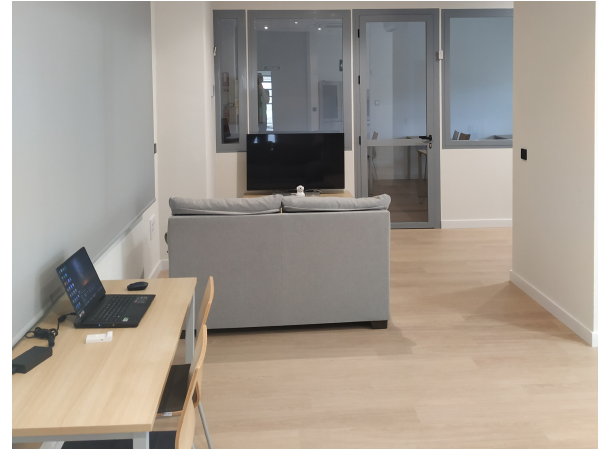
Figure 5. Hall & Living room.